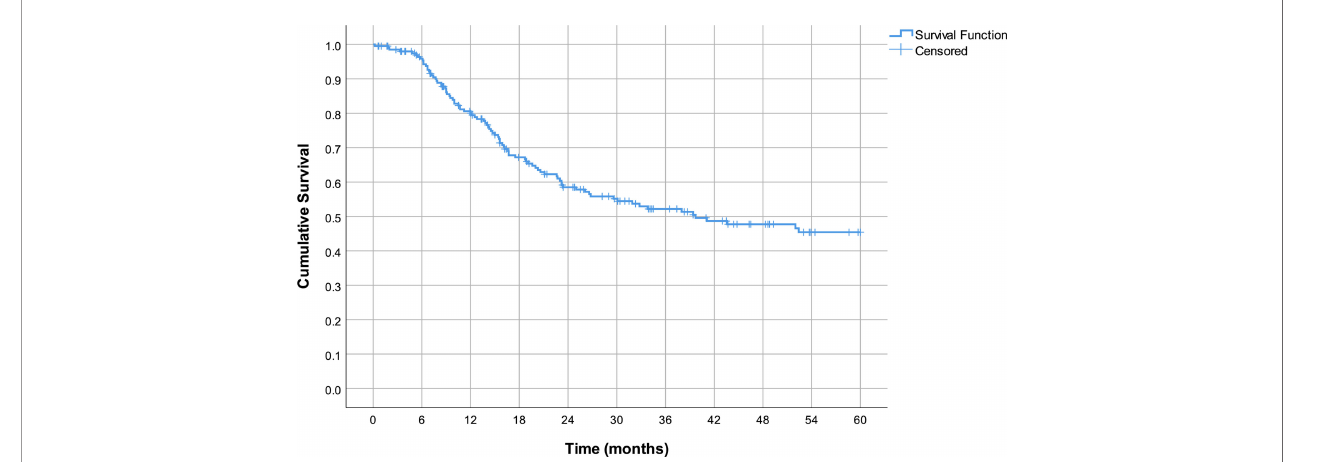
FIGURE 1 | Estimated mean overall survival.